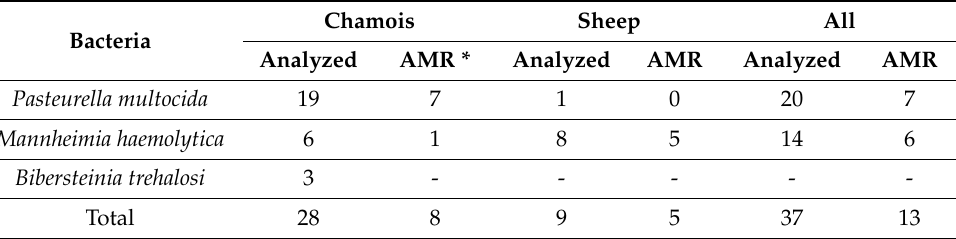
* Minimum inhibitory concentration ( µ g/mL), established by the CLSI guidelines: ceftiofur: ≥ 8 Pm / ≥ 8 Mh , peni- cillin: ≥ 1